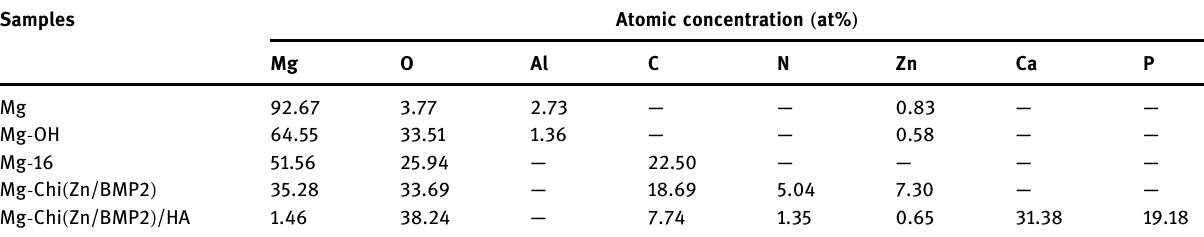
Table 1: Elemental compositions of the di ff erent samples Samples